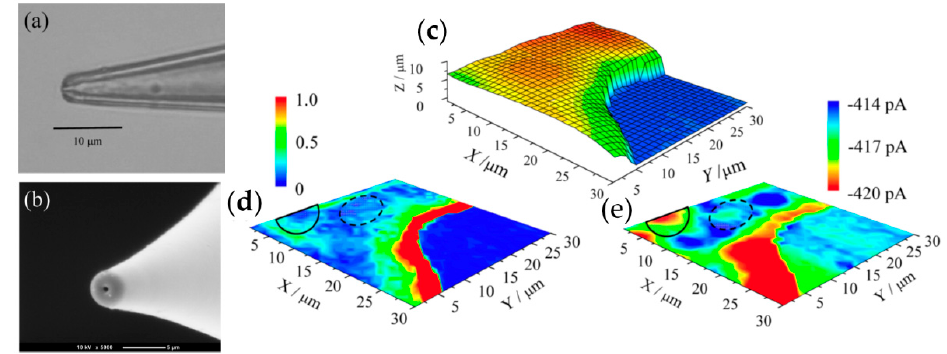
Figure 7. K + -selective nanoelectrodes were used to simultaneously image topography and K + flux using SECM. ( a ) Optical microscopy image of a glass capillary used as an ion-selective nanoelectrode for SECM. ( b ) SEM micrograph of the same tip. ( c ) Topography image. ( d ) Maximum gradient of